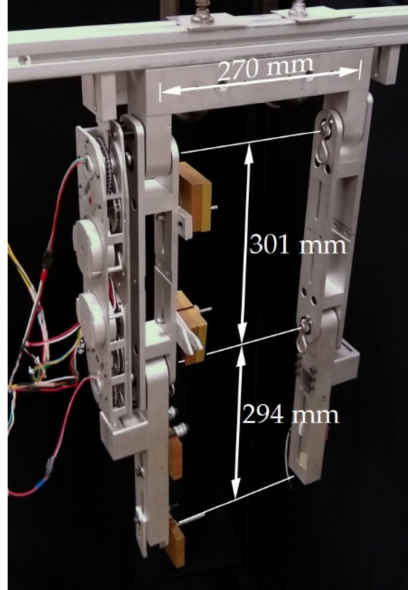
Figure 8. Photo of the actuators in the preliminary orthosis, attached to the pediatric test dummy